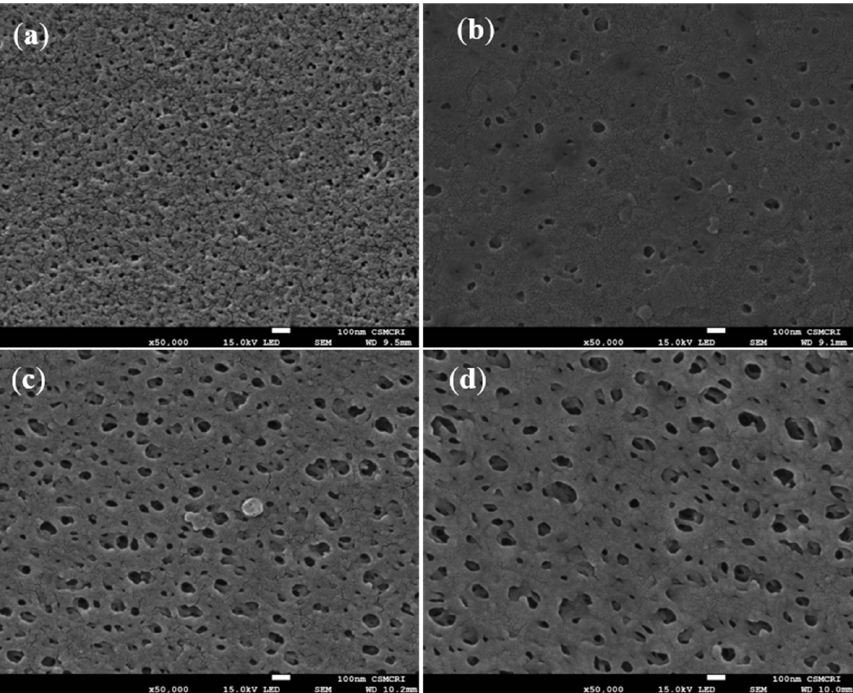
Figure 7. Scanning electron microscopy (SEM) images of the surface porosity of membranes at 50,000 × magnification: ( a ) PSF/Dia 0.0 , ( b ) PSF/Dia 0.1 , ( c ) PSF/Dia 0.2 , and ( d ) PSF/Dia 0.5